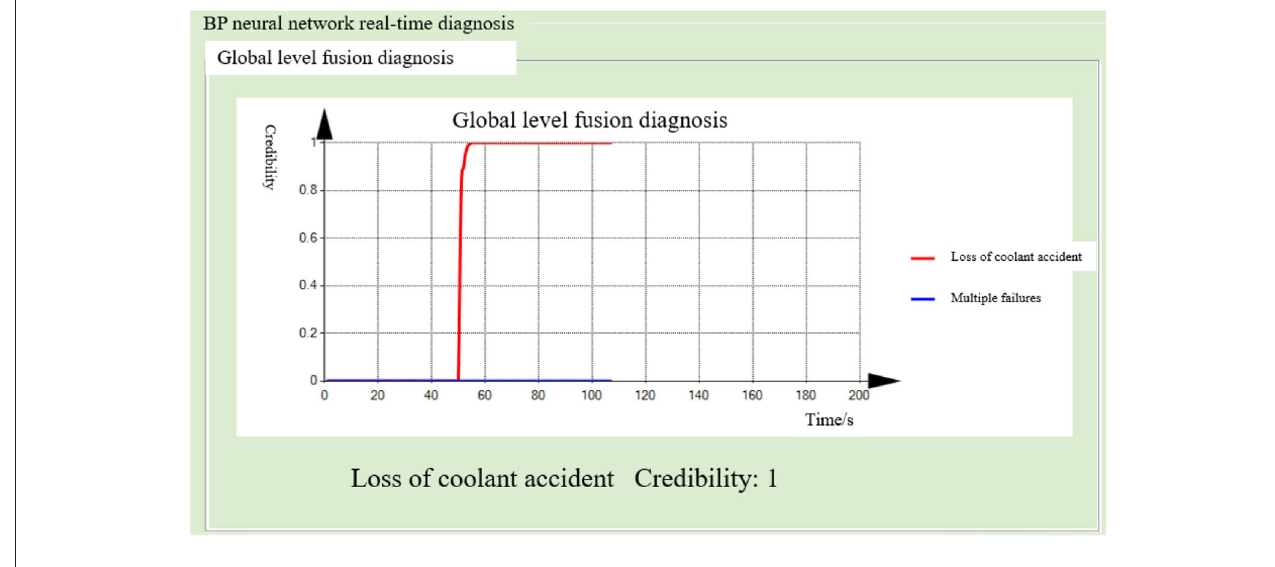
FIGURE 18 | Global-level fusion diagnosis result (BP neural network method).